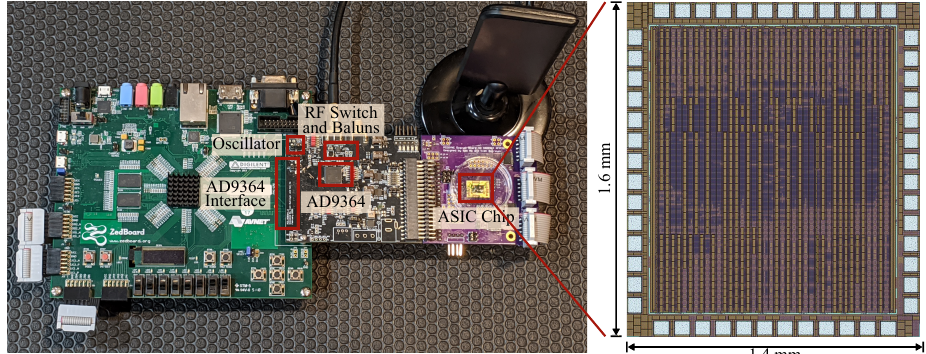
Figure 15. The implemented radio node consists of a ZedBoard, a custom RF PCB with AD9364, and an ASIC accelerator board, and is connected as shown in Figure 9. The ASIC chip is pad limited with 26.8% standard cell density in a 180nm six-layer CMOS process.